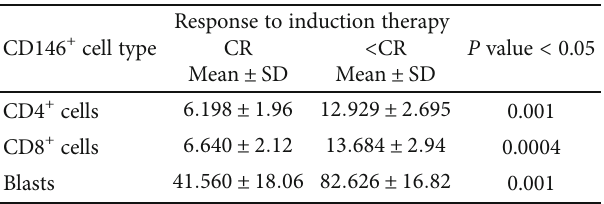
Table 4: Impact of the mean percentages of CD146 + cells in response to induction